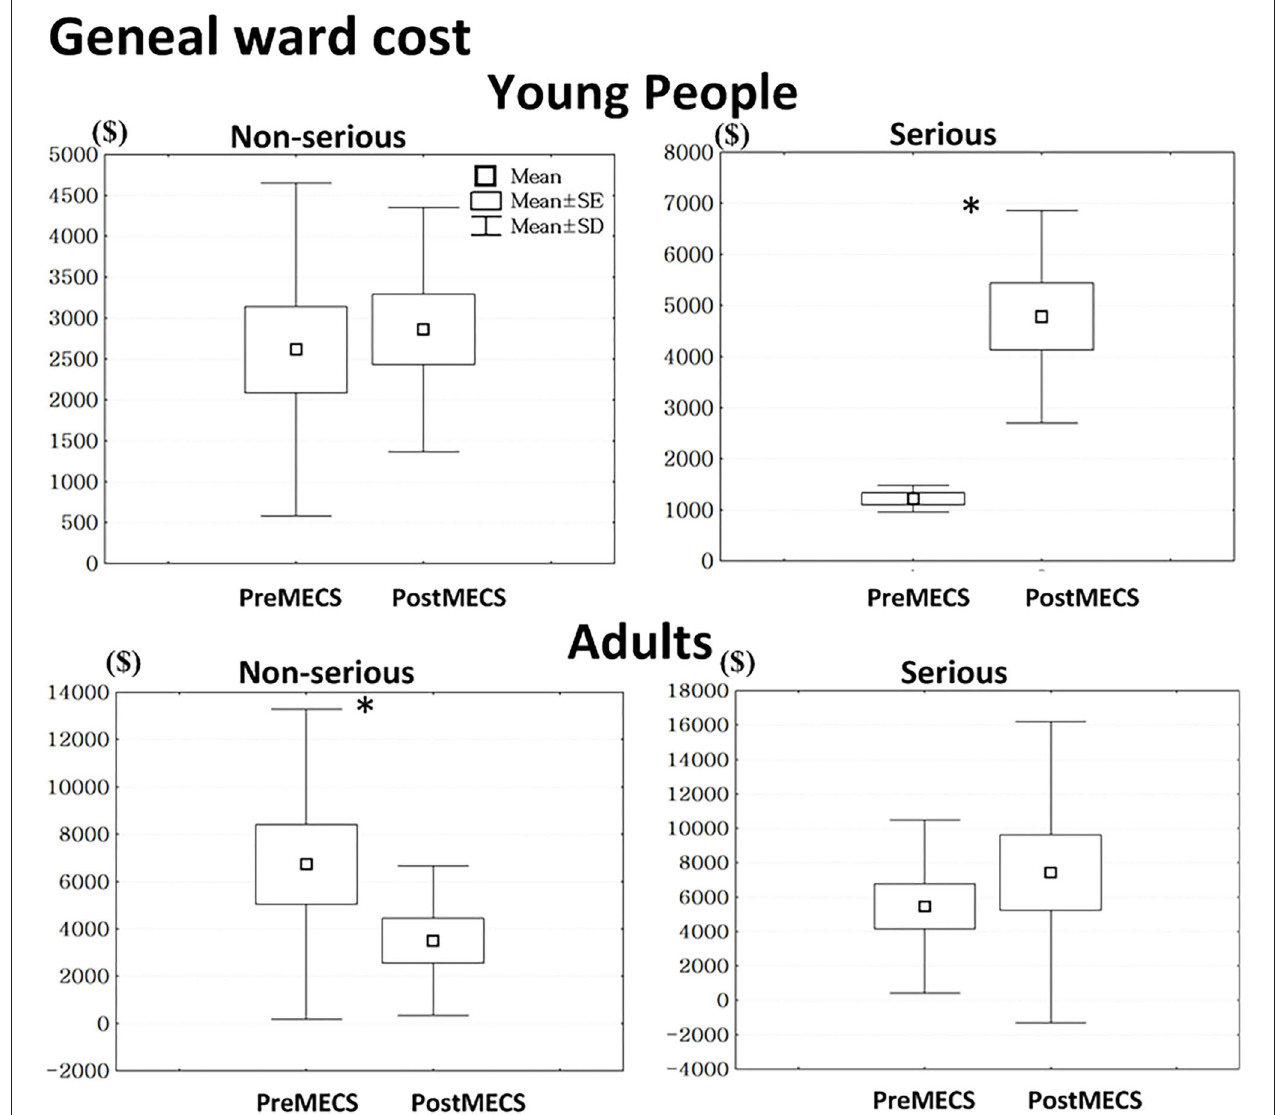
FIGURE 2 | We defined suicide attempts as being serious when showing both high intentionality and high lethality. Otherwise, we defined suicide attempts as non-serious. *Statistically significant, p < 0.05, MECS, multi-disciplinary emergency consultation system.